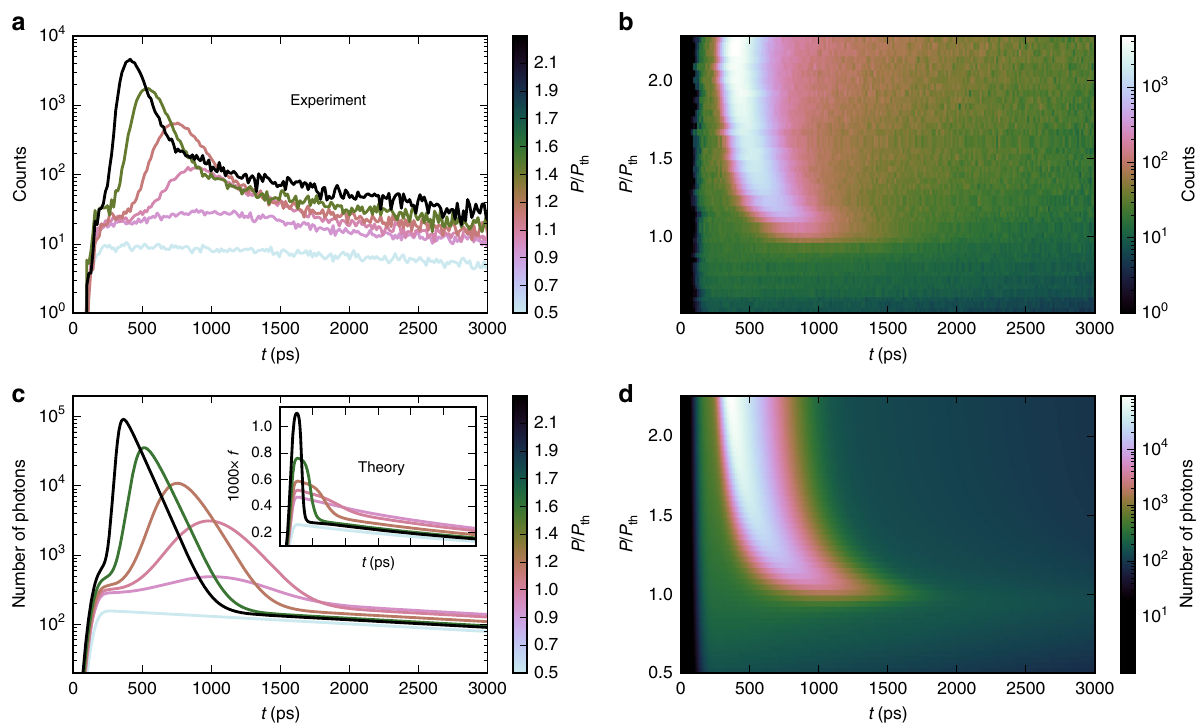
Fig. 3 Time-dependent cavity output intensity. The pump pulse sets the beginning of the time axis. We observe a delay in the growth of the photon condensate close to the critical excitation fraction P th , accompanied by a large pulse broadening. Experimental results are shown in a and b , while simulations of the mean- fi eld rate equations are shown in c and d . The inset depicts the experimentally inaccessible molecular excitation fraction f , during the same timespan as the main axes, demonstrating the two-way coupling between photons and molecules. The cavity ground state is located at 602 nm (cavity cutoff), the same conditions as in Fig. 2. Panels a , and c depict a subset of the data on b and d